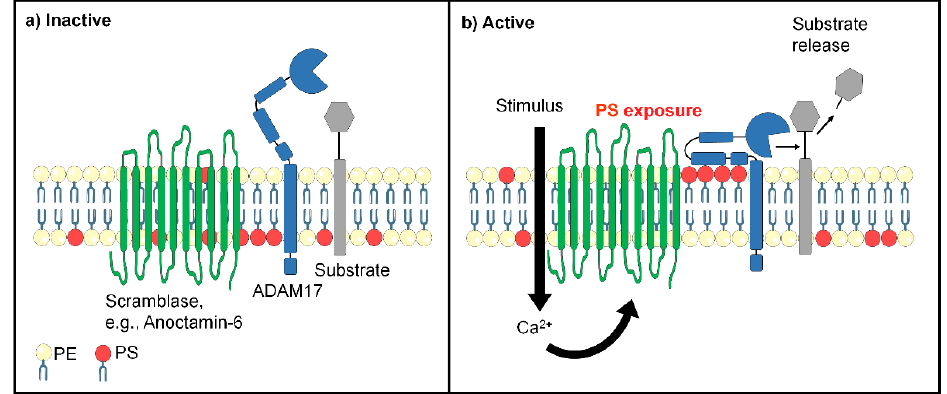
Figure 1. Proposed links between scramblase and ADAM17 function. ( a ) In non-activated cells, negatively charged phosphatidylserine (PS, red) is mainly sequestered in the inner cell membrane leaflet, while phosphatidylcholine (yellow) is mainly localized in the exoplasmic leaflet. ADAM17 (blue) has limited access to substrates. The ectodomain consists of a metalloprotease domain, a disintegrin domain, and a membrane-proximal domain (MPD) followed by a stalk region. ( b ) Cell stimulation can lead to scramblase activation and rapid loss of cell membrane asymmetry. Externalized PS electrostatically interacts with positively charged amino acids of ADAM17 and guides the enzyme to its